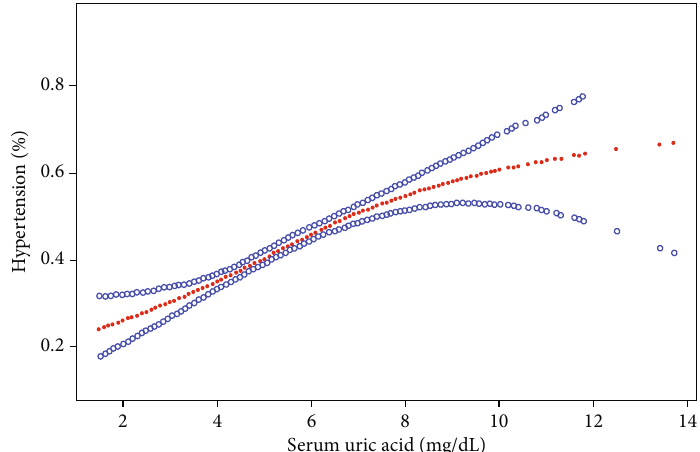
Figure 2: Association between sUA and HTN. The area between two blue dotted lines is expressed as a 95% CI. Age, sex, race, income- poverty ratio, physical activity, smoking behavior, alcohol consumption, diabetes mellitus status, body mass index, total cholesterol, serum homocysteine, urine creatinine, blood urea nitrogen, and total calcium were